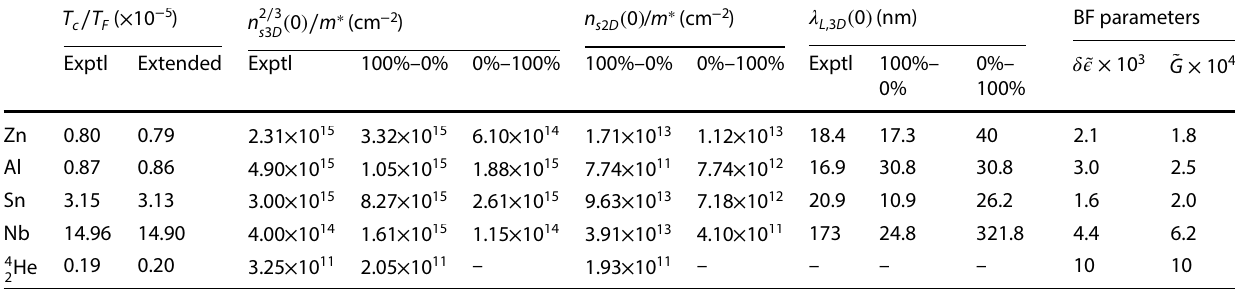
These are compared with empirical data of Uemura et al. [33] for four typical elemental SCs near the weak-coupling regime. Note that 3D cases reproduce the data trends while the 2D cases do not. For the ultracold atomic gas of 4 2 He atoms n ∕ n f ≃ 10 6 (strong-coupling regime) was used. Values for m ∗ ∕ m e for each SC are from Ref. [61] and for 4 2 He from [62]. Also listed is the penetration depth 𝜆 2 L ∝ m ∗ ∕ n s in 3D. The last two columns list the BF parameters for each superconductor